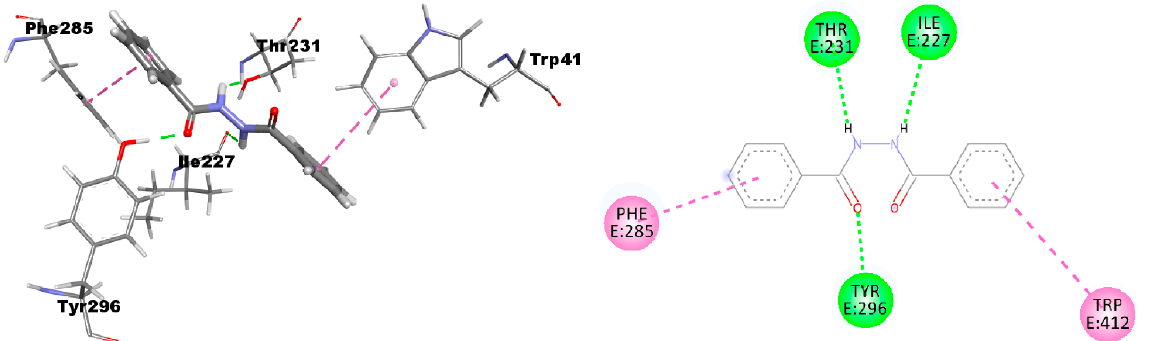
Figure 3. 3D and 2D pictures of the DBH interactions within the EcR receptor.